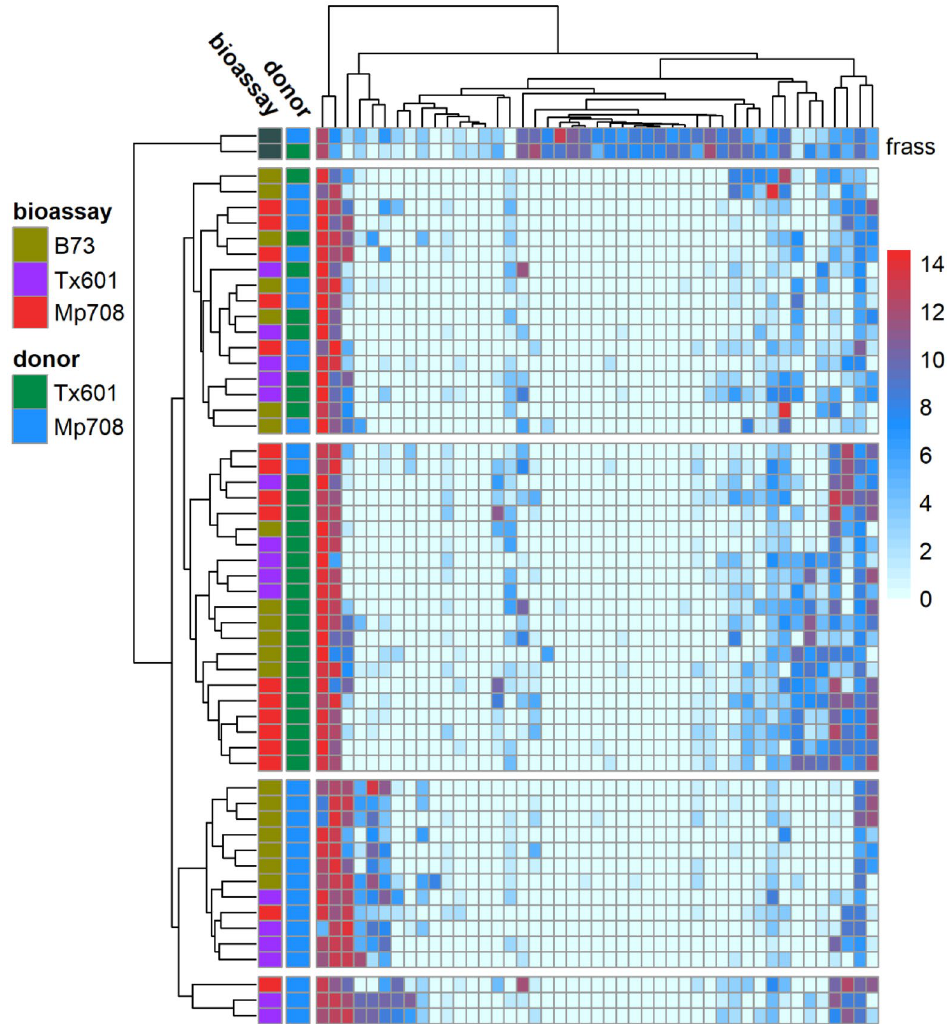
Figure 3. Heatmap showing abundance and distribution of the 100 most prevalent OTUs in fall armyworm guts. Donor indicates the feeding substrate of the fall armyworm larvae used to provide frass for transfer to recipients, while bioassay indicates the feeding substrate of the recipients. Clustering shows that the resulting microbes are influenced strongly by the donor and partially by the bioassay food substrate. The top cluster along the y-axis indicated by “F” are the pooled samples provided to the insects. The heatmap was constructed using log 2 (x + 1) transformed